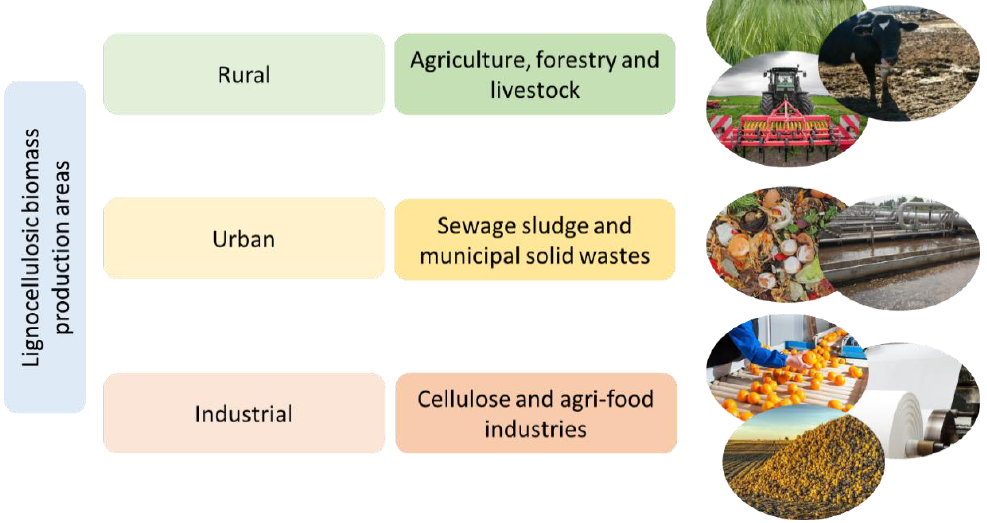
Figure 1. Lignocellulosic biomass production areas and wastes included in each category.